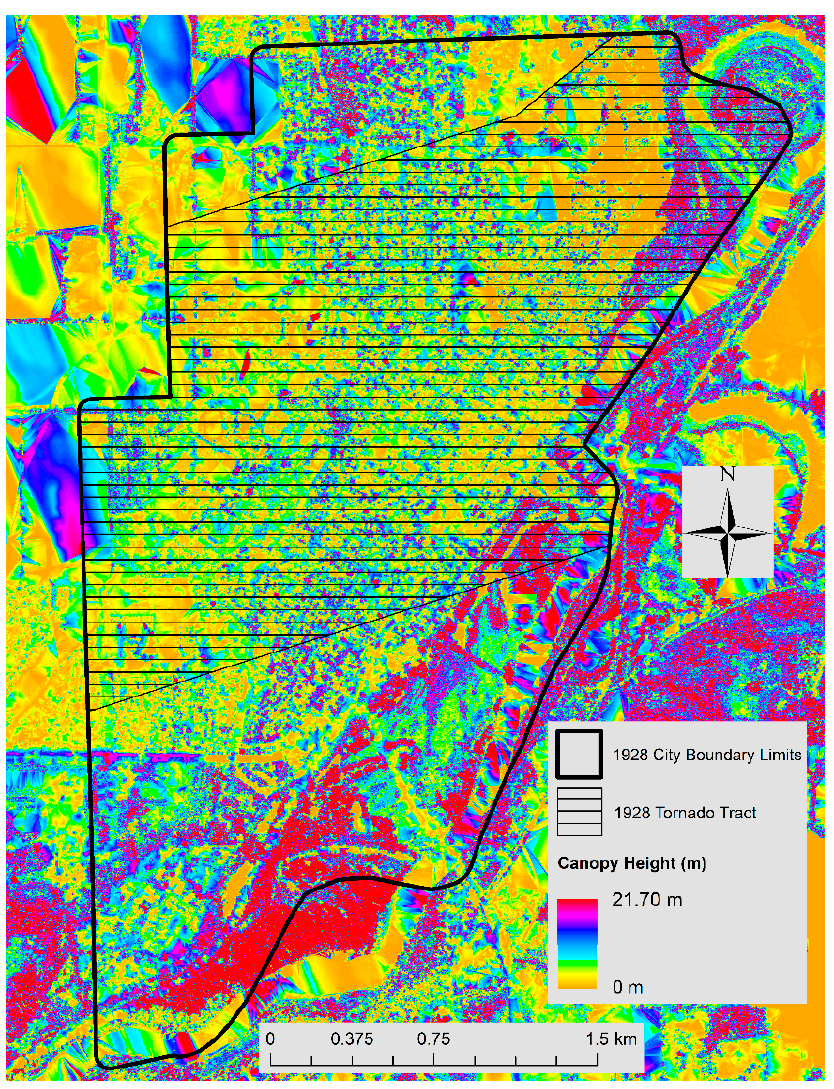
Figure 7. LiDAR canopy height model.